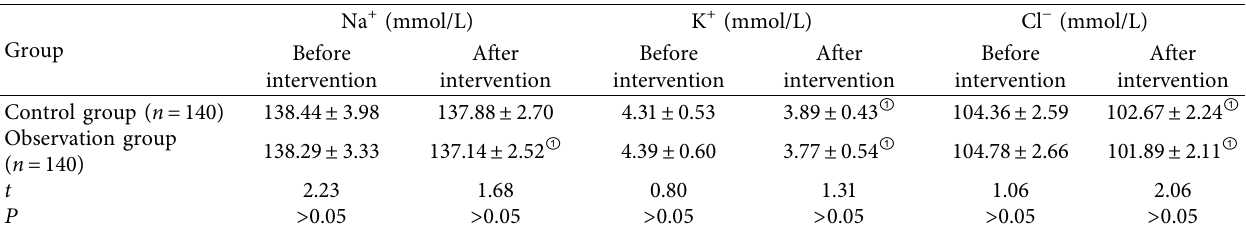
Table 3: Comparison of blood electrolyte indexes between the two groups before and after intervention ( x ± s ).